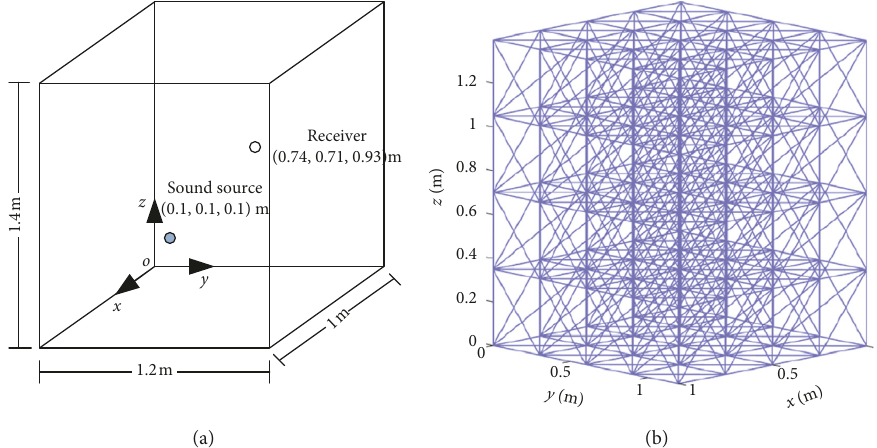
Figure 3: Schematics of the 3D cubic cavity and its discrete form. (a) The cubic cavity and its dimensions. (b) The tetrahedron elements of the fluid domain.